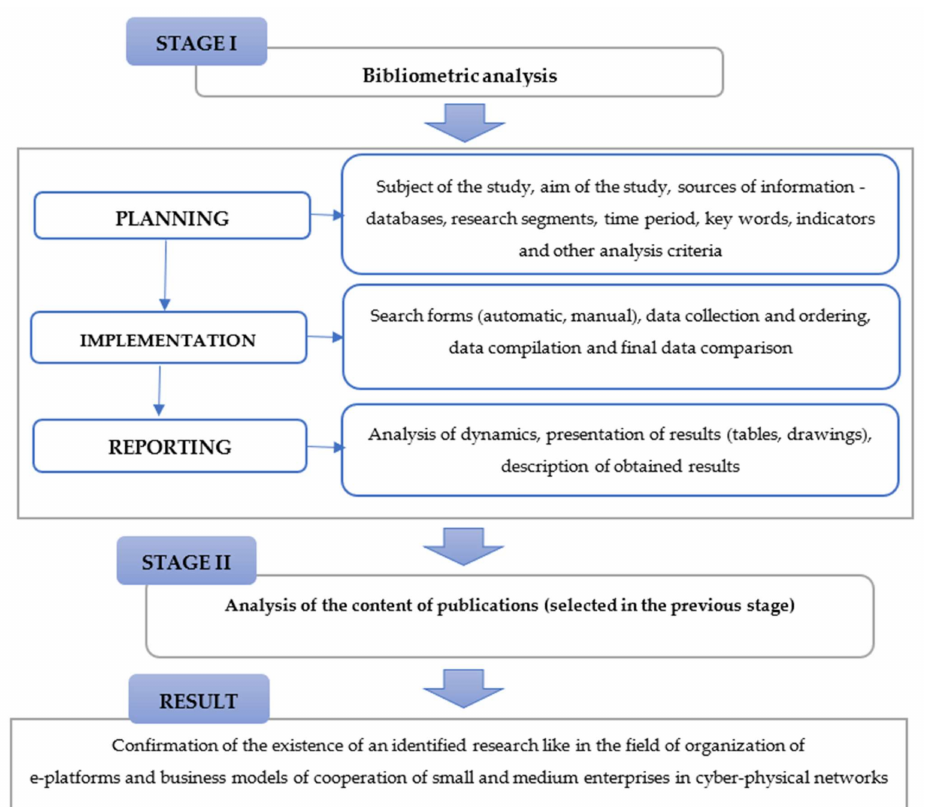
Figure 1. Bibliometric analysis based on methodology SLR. Source: own